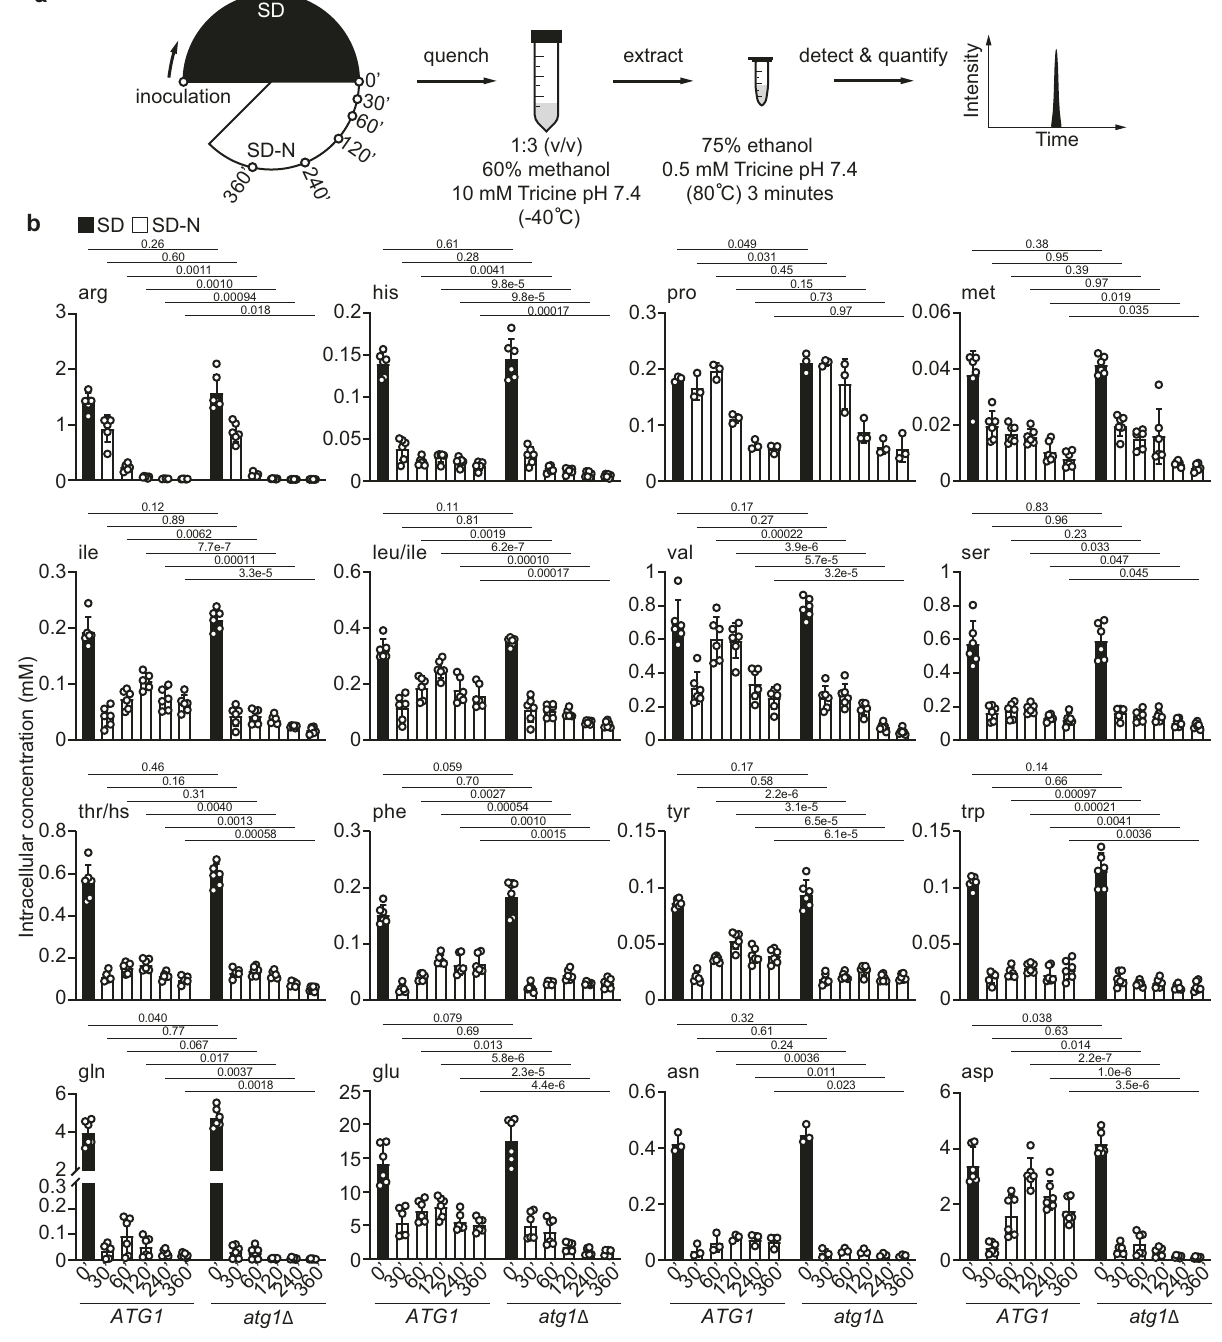
Fig. 1 Autophagy is crucial for maintaining amino acid pools under nitrogen starvation. a Schematic of the experimental design. WT ( ATG1 ) and atg1 Δ cells were grown in synthetic de fi ned medium (SD) and starved for nitrogen (SD-N) for varying times. Metabolites were extracted and analyzed by LC- MS/MS. b Changes of amino acids in nitrogen-starved WT and atg1 Δ cells. Three independent replicates for pro and asn, and six for the remaining amino acids. Absolute concentration was calculated based on Supplementary Fig. 3b by comparing different time points of WT and atg1 Δ cells to WT grown in SD. WT and atg1 Δ cells were always processed and analyzed together and therefore their abundances are directly comparable. hs: homoserine. P values were calculated using unpaired two-sided Student ’ s t test assuming equal variances. Data are presented as mean ± standard